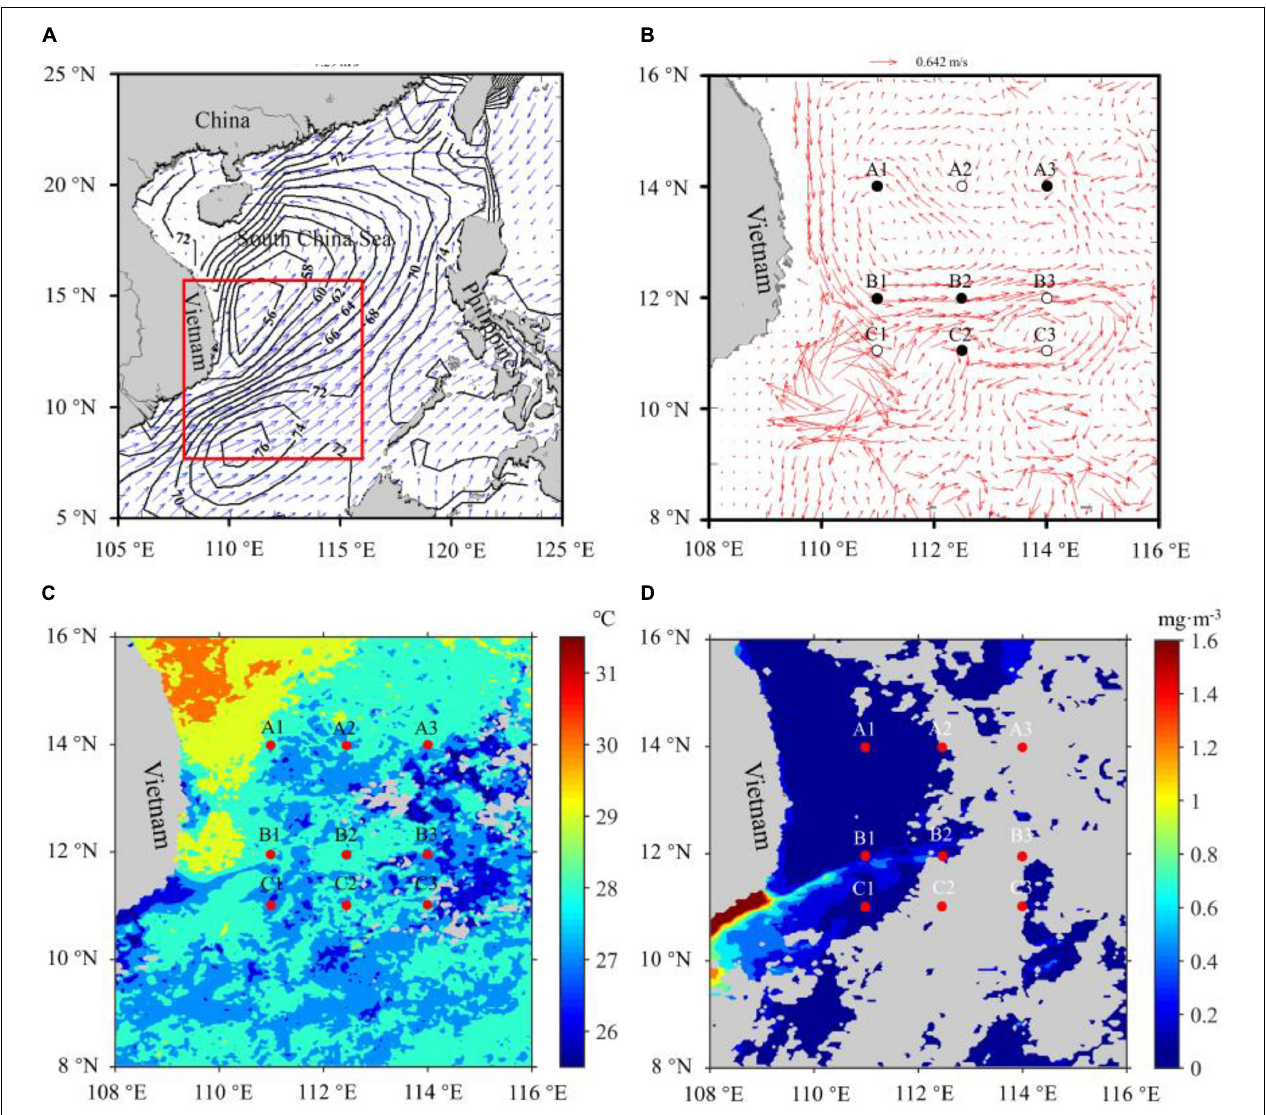
FIGURE 1 | Monthly mean wind field and sea surface height (black isoline, cm) in the sampling regions (red box) (A) . Monthly mean ocean currents and sampling stations, circles, and black dots mean that samples were collected in the daytime and nighttime (B) . Monthly mean surface temperature (C) and surface chlorophyll concentration (D) in the sampling regions, and the red dots represented sampling stations. Gray color means the missing value (D)